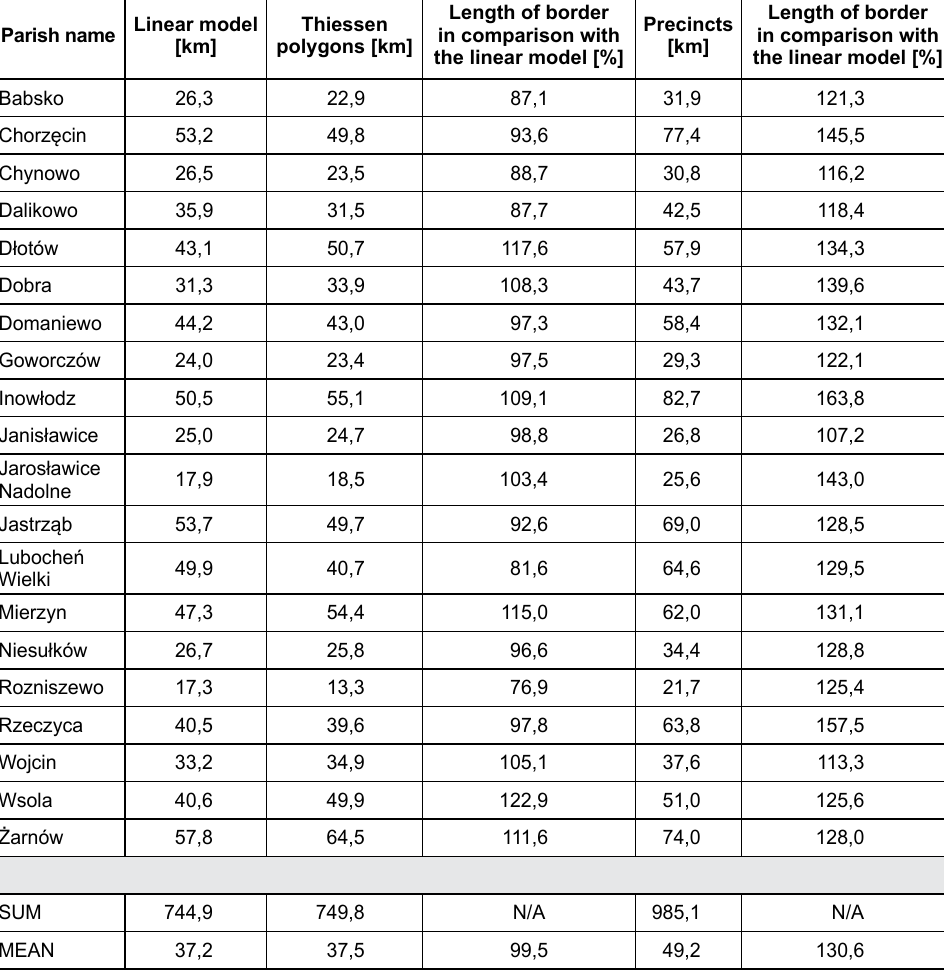
Table 2. Length of borders according to analysed methods (20 random parishes) Linear model Parish name